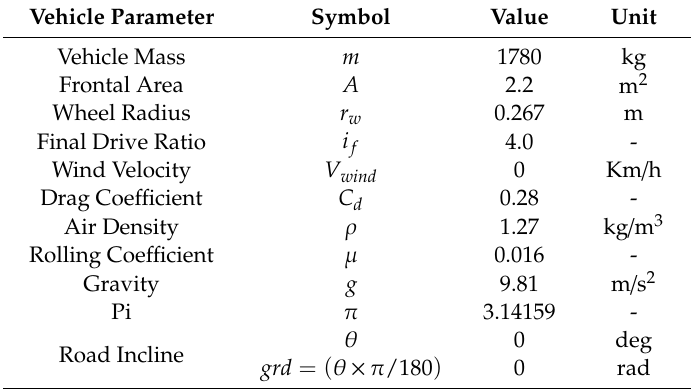
Table 2. Vehicle parameter.